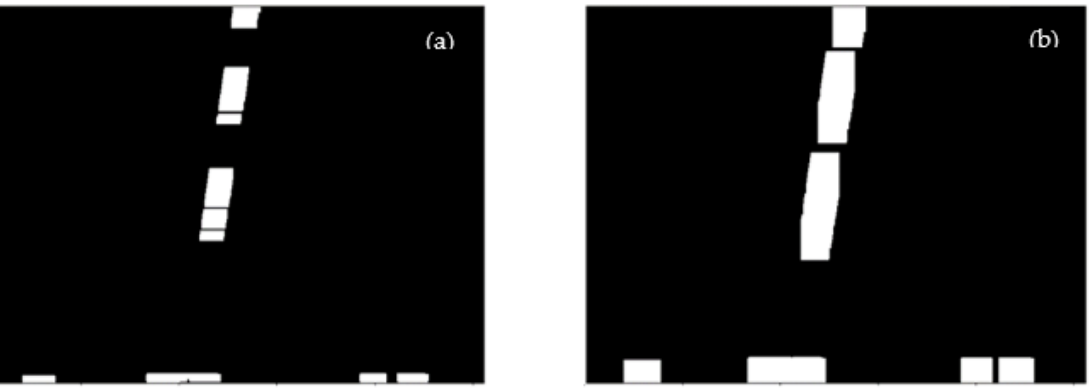
Figure 9. The effect after expansion operation. ( a ) The image in Figure 8d by horizontal expansion. ( b ) The image from ( a ) in this figure by vertical expansion.